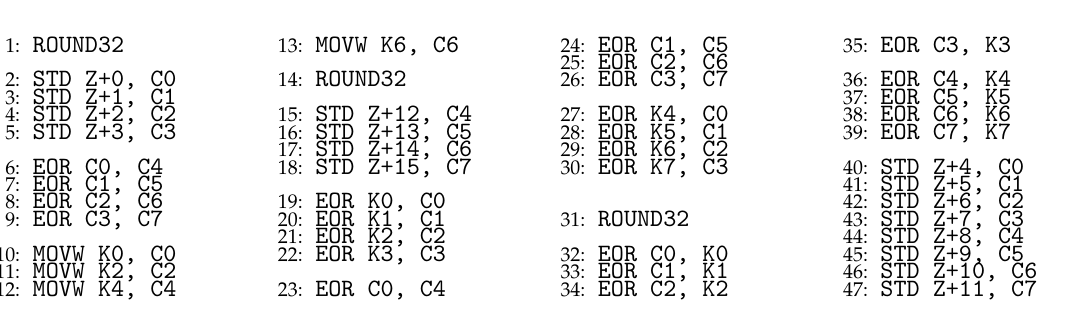
Algorithm 2 Proposed implementation of 1-level Karatsuba Block-Comb in source code